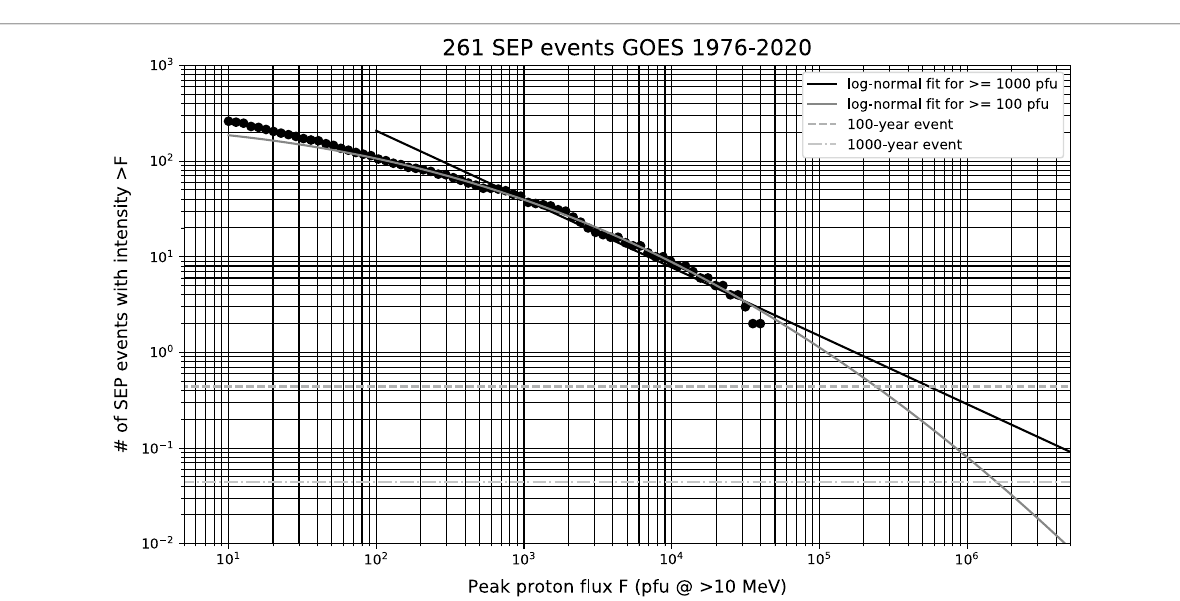
Fig. 8 Cumulative distribution function of SEP events at GOES for time interval 1976 to 2020. The data points are displayed at even intervals in logarithmic scale. Log-normal and power-law fits are shown by thick and thin solid curves, respectively. The best fitted parameters are α μ 1.7, and σ 1.2 = =